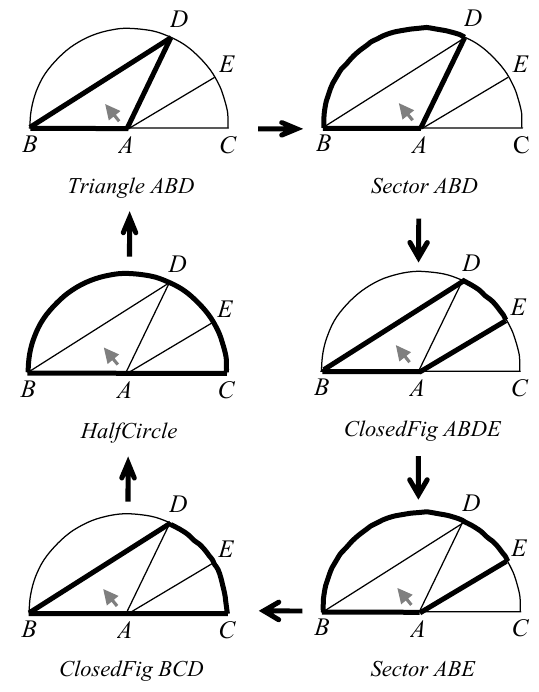
Fig. 3. Mouse toggles around the closed figures surrounding the mouse point.